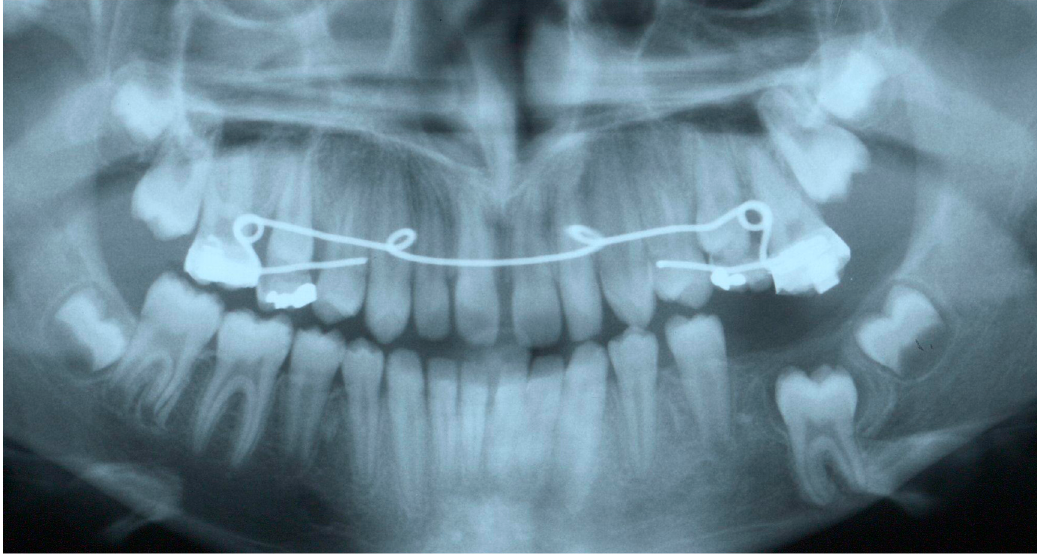
Figure 3. Panoramic radiograph after the extraction of the mandibular deciduous molars with the Quad-helix appliance.